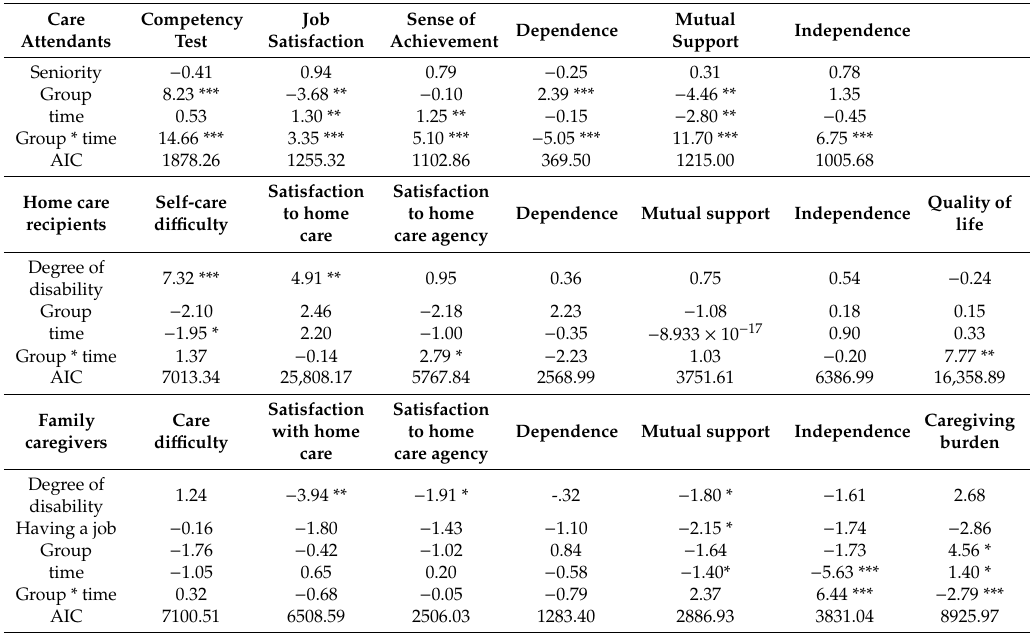
Table 5. E ff ects of self-reliance support intervention on the care attendants, care recipients, and family caregivers by the generalized estimating